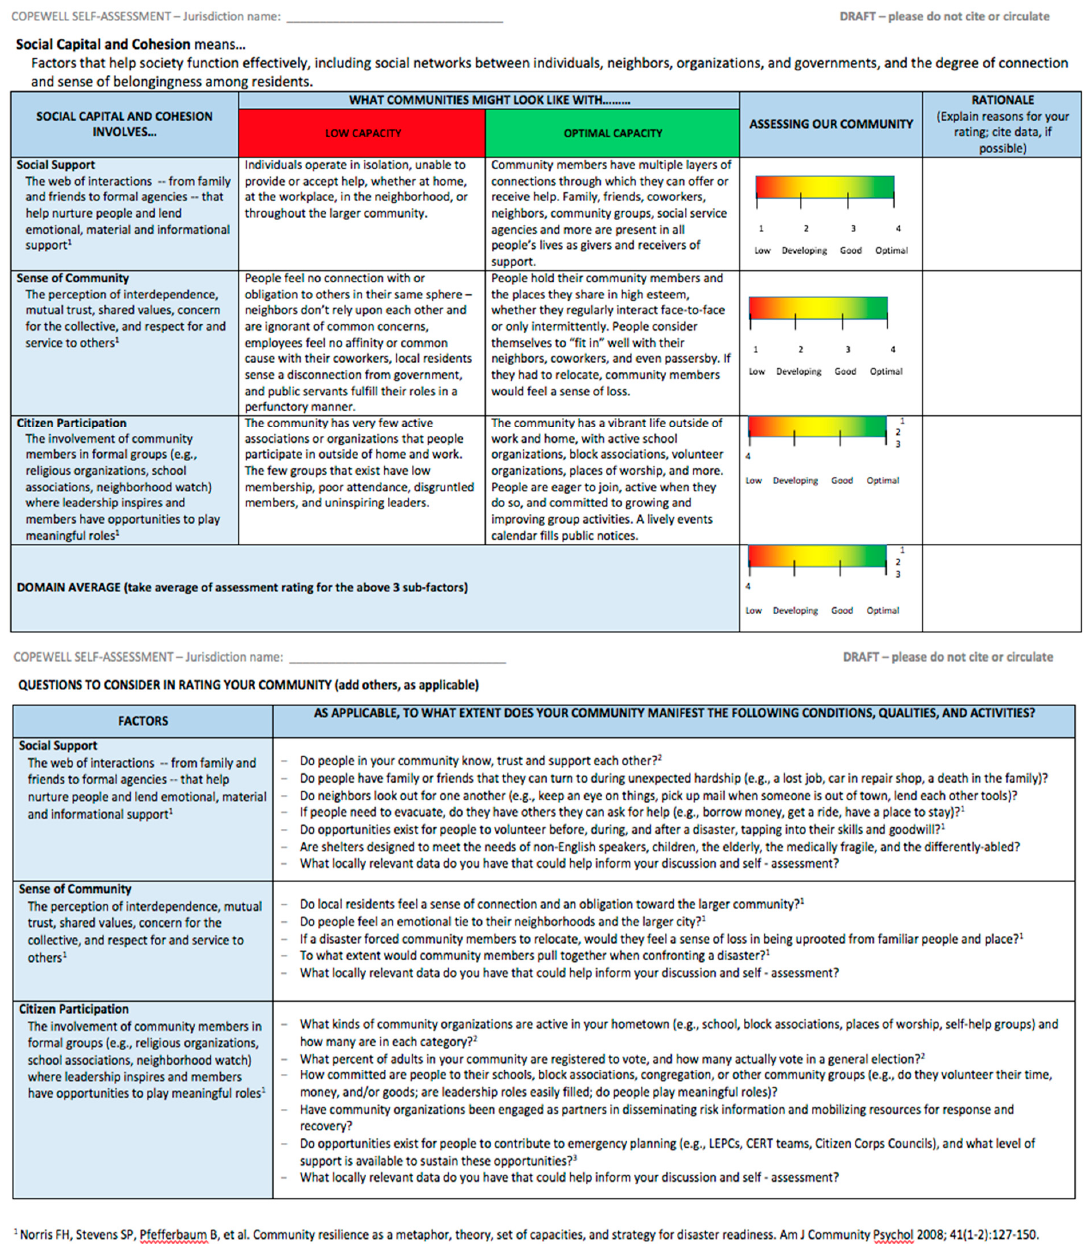
Figure 3. Self-Assessment Instrument for the Social Capital and Cohesion Domain of the